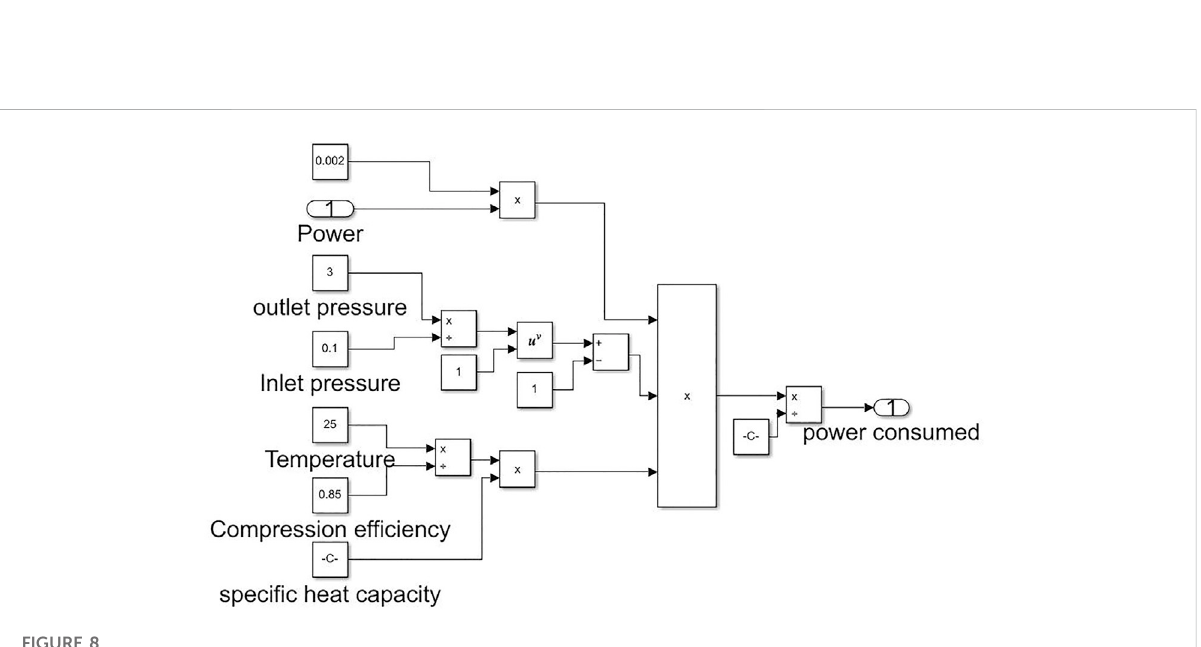
FIGURE 8 Hydrogen storage tank